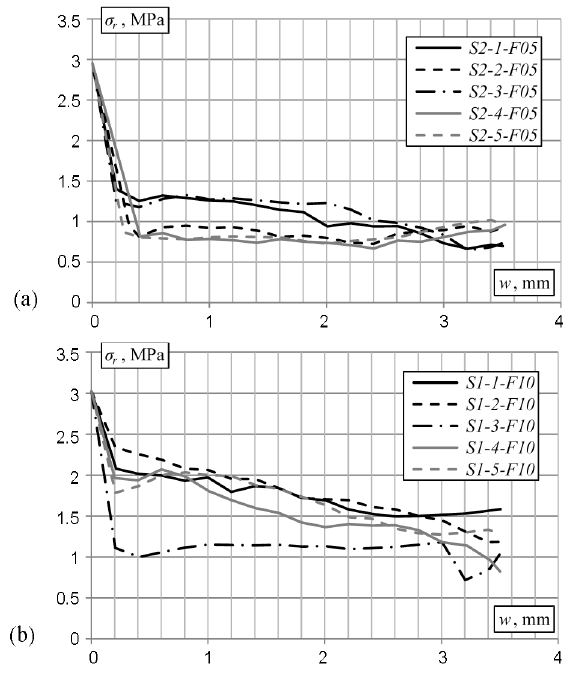
Fig. 5. Experimentally obtained load-crack opening width rela- tionships for the test specimens with 0.5% (a) and 1.0% (b) fibre volumes